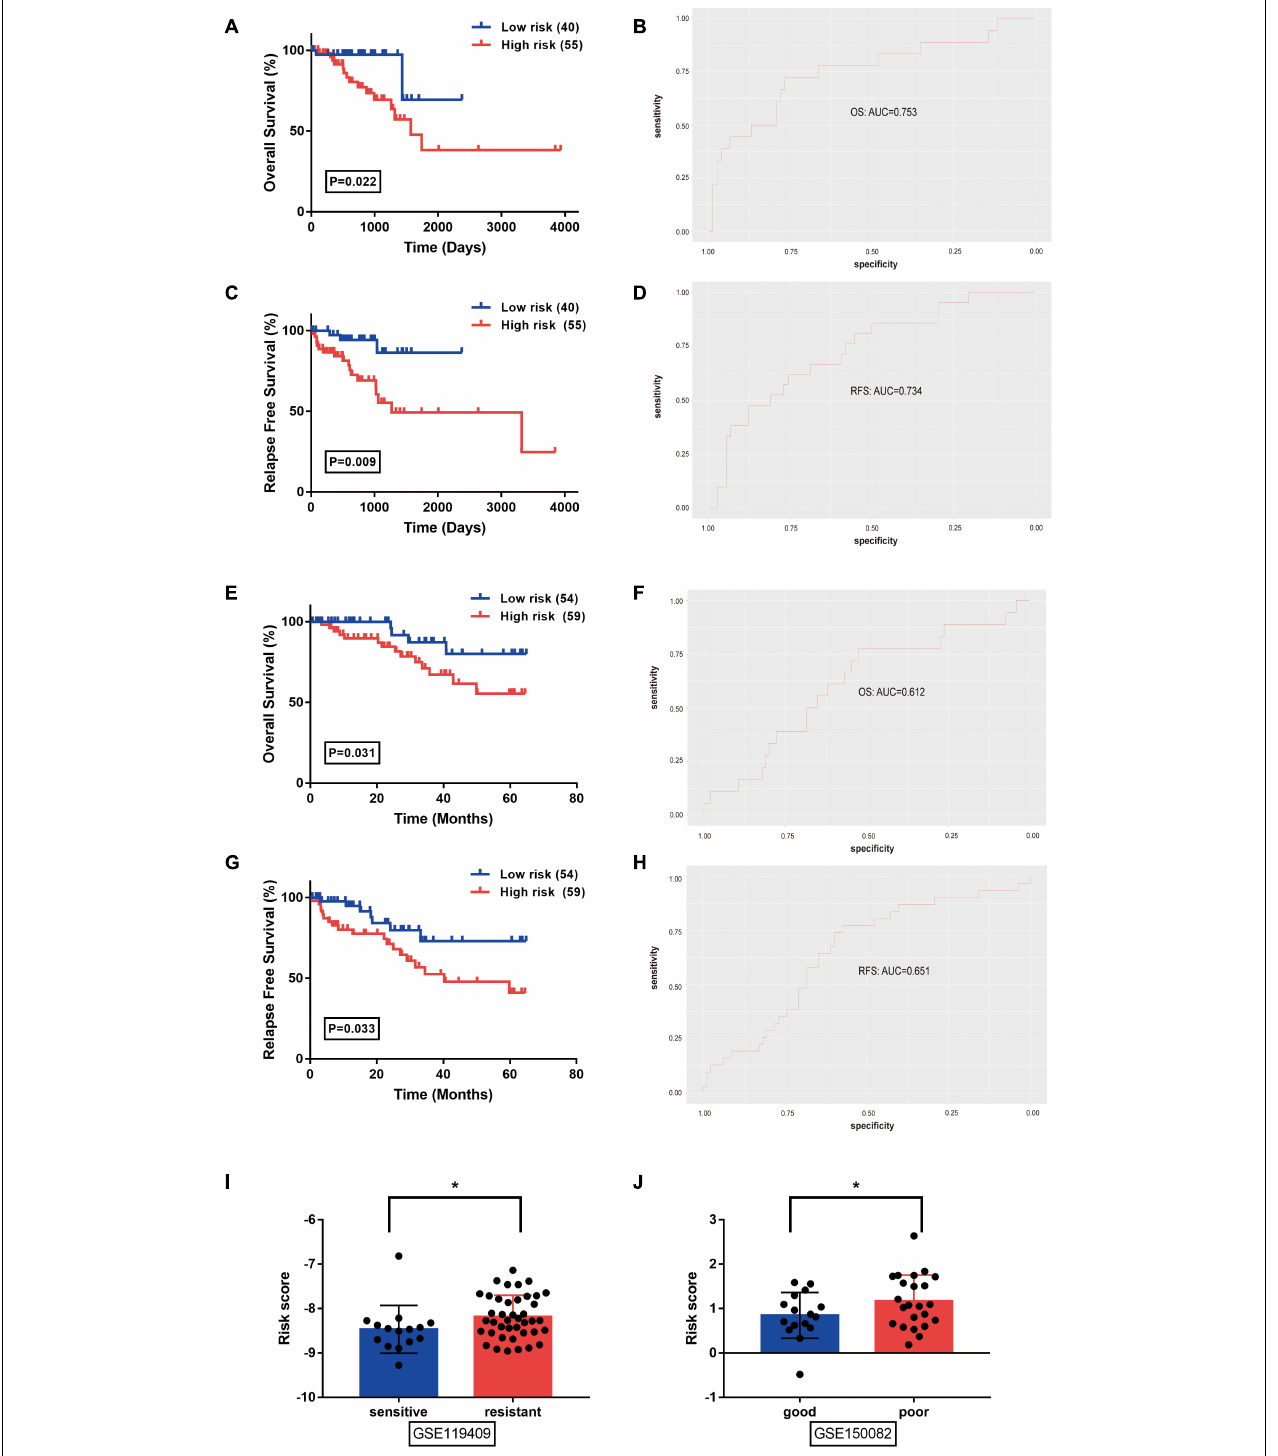
FIGURE 3 | Prognostic value of the identified signature was evaluated in rectal cancer from the TCGA-READ (A–D) , GSE87211 (E–H) , GSE119409 (I) , and GSE150082 (J) datasets. (A,E) Overall survival analysis between low- and high- risk groups stratified by the risk score. (B,F) The receiver operating characteristic (ROC) curve was used to evaluate the predictive efficiency of the overall survival rate. (C,G) Relapse free survival analysis between low- and high- risk groups stratified by the risk score. (D,H) The ROC curve was used to evaluate the predictive efficiency of relapse free survival rate. (I) The distribution of risk score in rectal cancer patients stratified by the response to neoadjuvant radiotherapy (unpaired T-tests). (J) The distribution of risk score in locally advanced rectal cancer patients tratified by the response to chemoradiotherapy (unpaired T-tests). * P < 0.05.